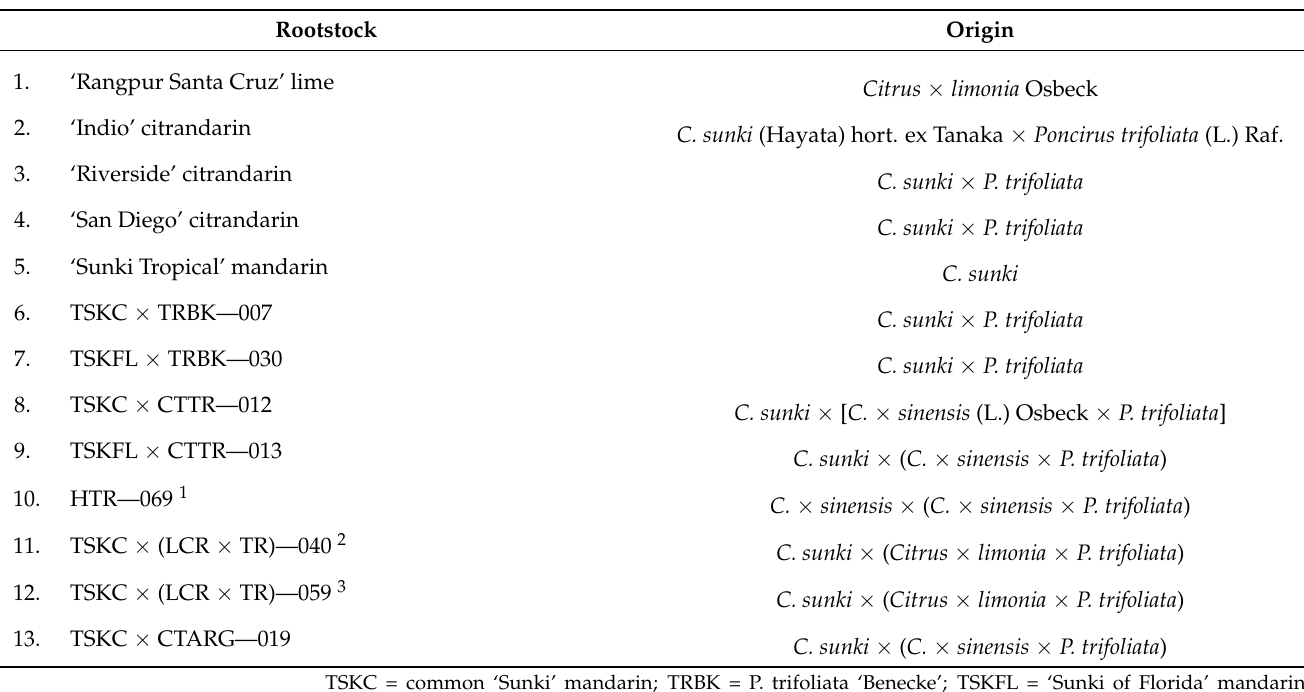
Table 1. Rootstocks (genotypes) studied under water salinity when grafted on ‘Tahiti’ acid lime ( Citrus × latifolia (Yu. Tanaka) Tanaka).